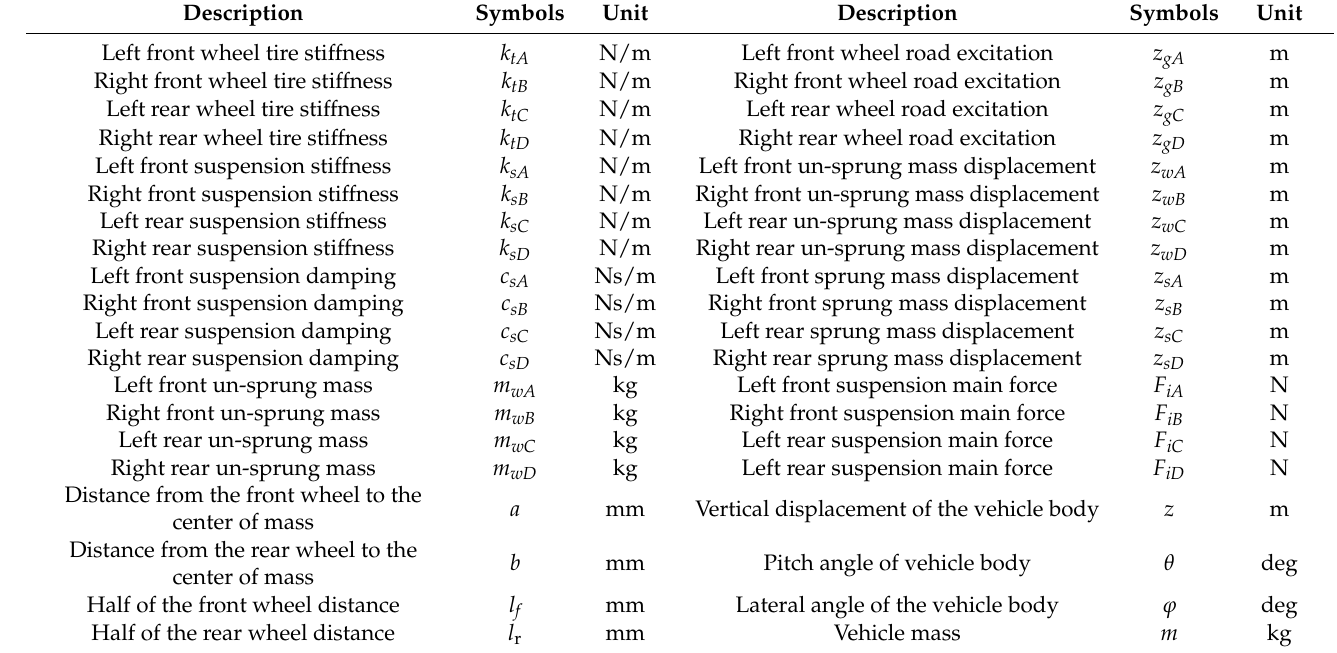
Figure 1. Schematic of the 7-DOF full-car suspension system. Descriptions and units of each parameter in Figure 1 are shown in Table 1. Table 1. 7-DOF vehicle parameters.